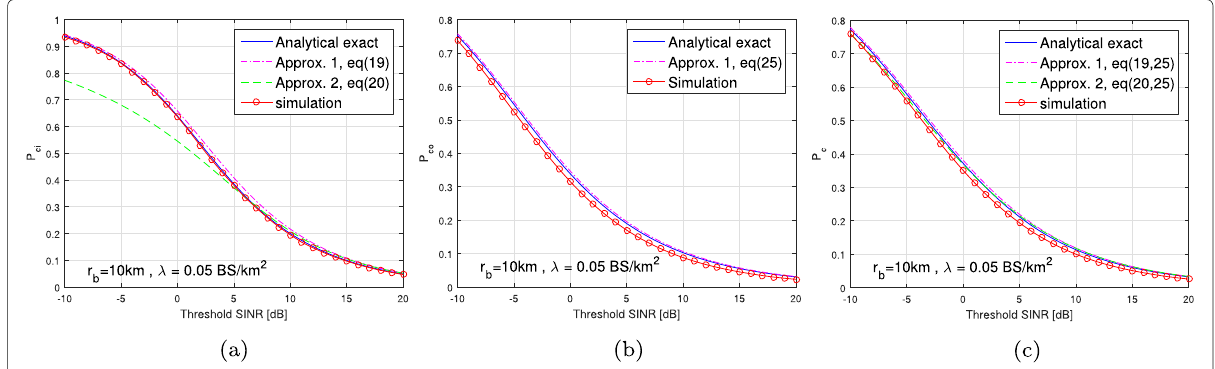
Fig. 5 General user P c . CCDF of probability of coverage P c for shared spectrum scenario a Inside users P c / i b Outside users P c / o c General user P c